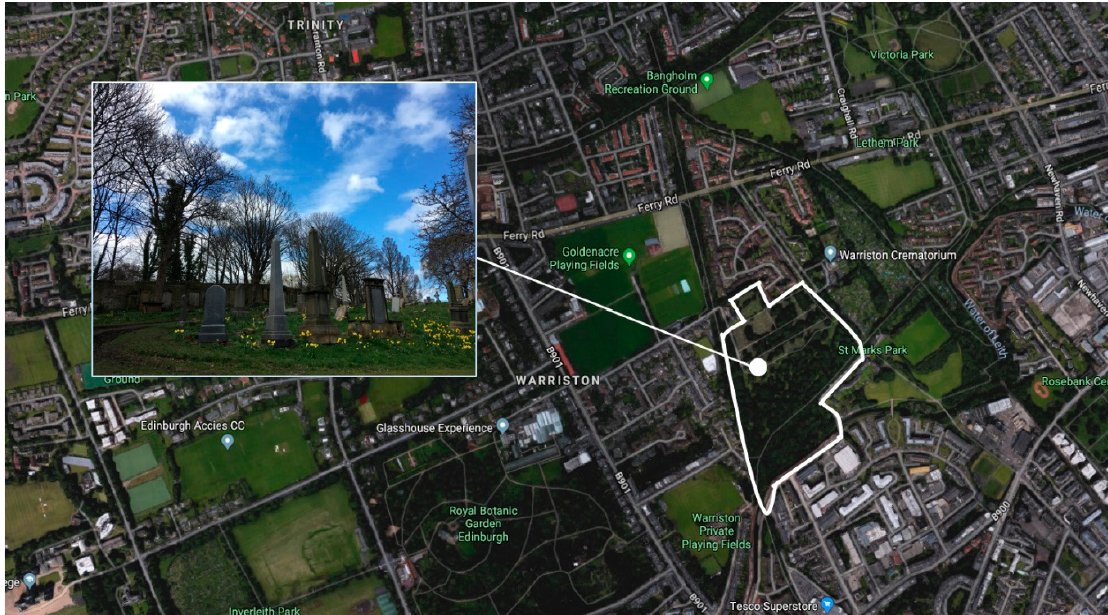
Figure 2. Map and image of the Warriston Cemetery in Edinburgh (the map was retrieved from www.google.no/maps/). The white spot indicates the location where data collection was conducted, and the white line indicates the boundary of the Warriston Cemetery.